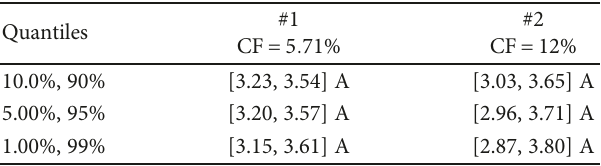
Table 1: The estimate of the con fi dence intervals based on quantile